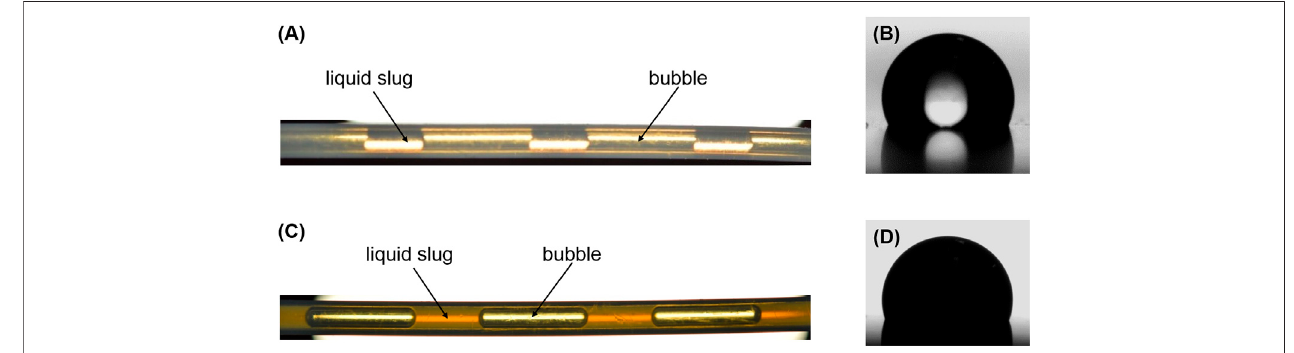
FIGURE 5 | (A) Picture of N 2 -water slug fl ow in the PTFE microchannel ( d c (cid:1) 0.8 mm). (B) Static contact angle of water on PTFE ( θ (cid:1) 108.0 ° ). (C) Picture of N 2 – TiO 2 /H 2 Onano fl uid( φ (cid:1) 0.05 vol%)slug fl owinthePTFEmicrochannel( d c (cid:1) 0.8 mm). (D) Staticcontactangleof0.05vol%TiO 2 /H 2 Onano fl uidonPTFE( θ (cid:1) 72.5 ° ). In (A) and (C) , the fl ow direction is from left to right, Q g (cid:1) 2.77 ml/min, the water fl ow rate ( Q w ) and nano fl uid fl ow rate ( Q nf ) are both at 1.5 ml/min.